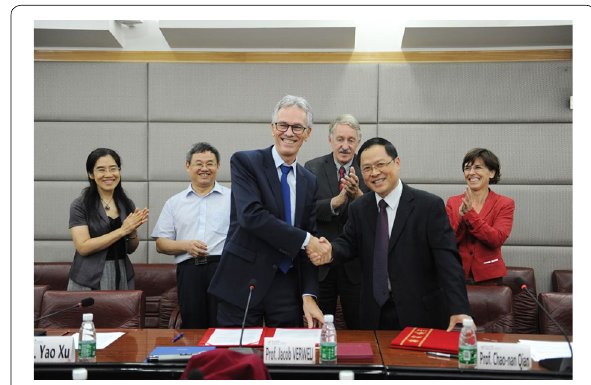
Fig. 1 Prof. Dr. Jaap Verweij (Dean of the Erasmus Medical Center executive board; left in the front ) and Prof. Chao-Nan (Miles) Qian (Vice President of the Sun Yat-sen University Cancer Center; right in the front ) congratulate each other with the signing of the Sino-Dutch collaboration agreement between these two institutions. From left to right in the back: Ms. Yao Xu (Deputy Director, Office of Interna- tional Cooperation and Exchange, Sun Yat-sen University), Prof. Limin Zheng, (Biotherapy Center, Sun Yat-sen University Cancer Center), Mr. Peter Boostma (Health, Welfare and Sport Counselor at Embassy of the Kingdom of the Netherlands in China), Mrs. Marjo Crompvoets (Consul General of the Kingdom of the Netherlands in Guangzhou)